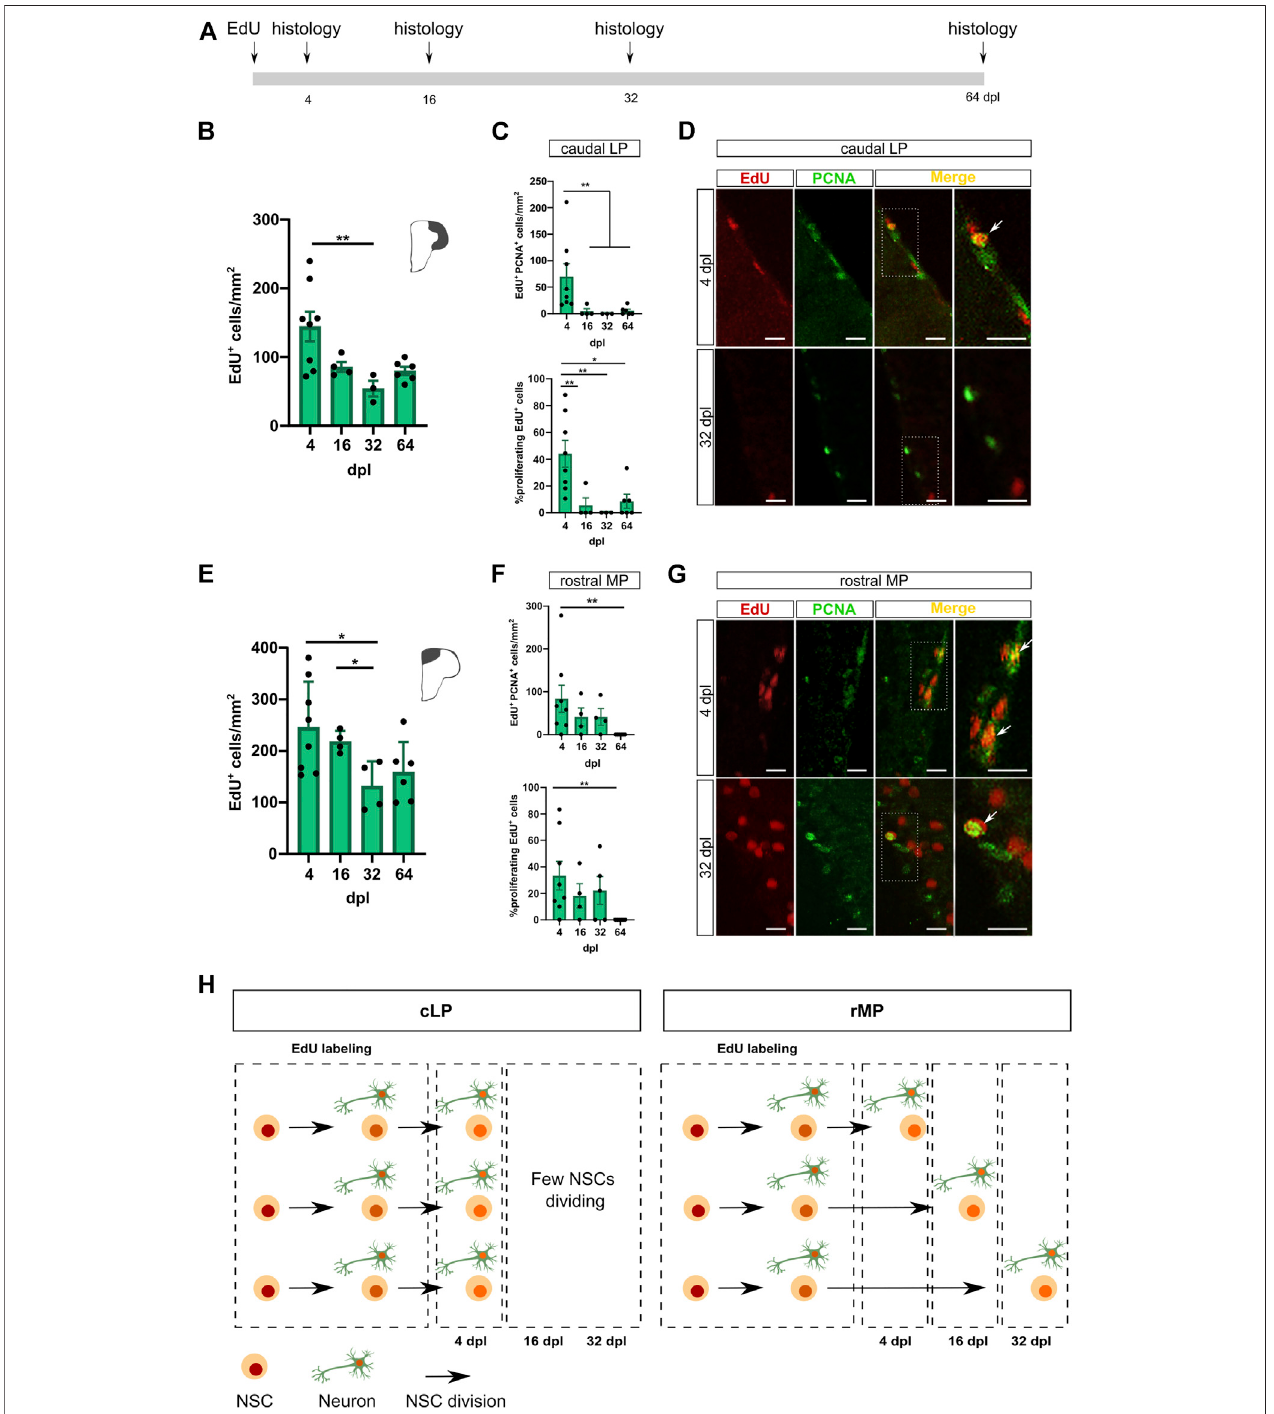
FIGURE 5 | Balance of adult neurogenesis driven by chained proliferation and loss of adult-born cells. (A) . Experimental design. Fish were i. p. injected with EdU andeuthanised forhistologyatthreetimespoints:4,16,32and64dpl. (B) .EdU + cellquanti fi cationincLPin4,16,32and64dpl.(Kruskal – Wallistest,followedbypost- hoc Dunn ’ s test, K-W st = 9.048, ** depicts p < 0.01. 4 dpl, N = 8; 16 dpl, N = 4; 32 dpl, N = 3, 64 dpl, N = 6). (C) . Number of proliferating EdU cells (top) and % of proliferating EdU cells (bottom) (Kruskal – Wallis test, followed by post-hoc Dunn ’ s test, K-W st = 13.80 and K-W st = 12.88, respectively. * depicts p < 0.05, **, p < 0.01.4dpl,N=8;16dpl,N=4;32dpl,N=3,64dpl,N=6). (D) .EdU/PCNAincLPfor4dpland32dpl.Scalebar,20 μ m. (E) .EdU + cellquanti fi cationinrMPin4,16,32 and64dpl.(Kruskal – Wallistest,followedbypost-hocDunn ’ stest,K-Wst=7.88,*depicts p < 0.05.4dpl,N=8;16dpl,N=4;32dpl,N=4,64dpl,N=6). (F) .Number of proliferating EdU cells (top) and % of proliferating EdU cells (bottom) (Kruskal – Wallis test, followed by post-hoc Dunn ’ s test, K-W st = 9.571 and K-W st = 8.827, respectively. ** depicts p < 0.01. 4 dpl, N = 8; 16 dpl, N = 4; 32 dpl, N = 3, 64 dpl, N = 6). (G) . EdU/PCNA in rMP for 4 dpl and 32 dpl. Scale bar, 20 μ m. (H) . Scheme summarizing EdU/PCNA results in cLP and